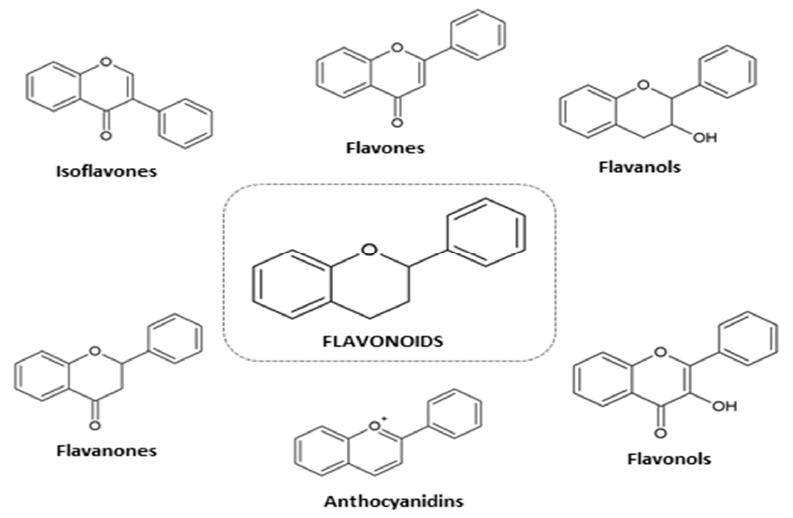
Figure 1. Chemical structure of the different classes of flavonoids.